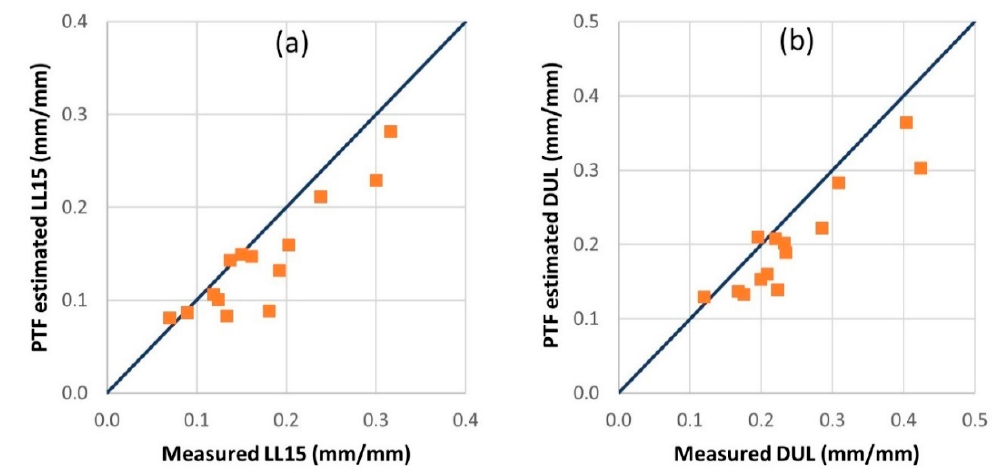
Figure 4. Relationship between the measured and PTF-estimated soil hydraulic parameters (whole soil profile) of the selected soil profiles; ( a ) lower limit (LL15) and ( b ) drainage upper limit (DUL).